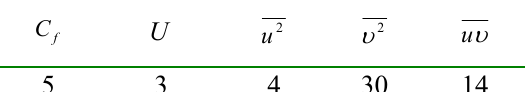
Table 1: Experimental Uncertainties (%)